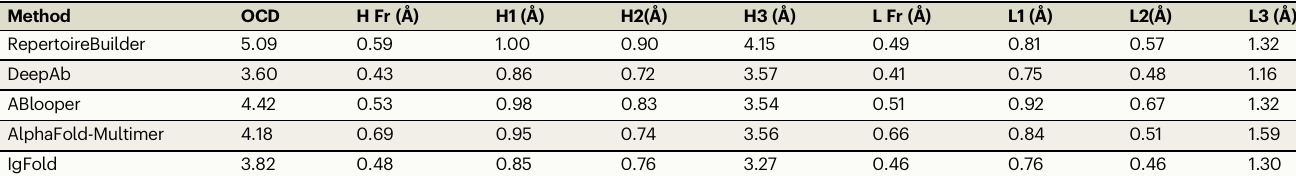
Table 1 | Accuracy of predicted antibody Fv structures Method